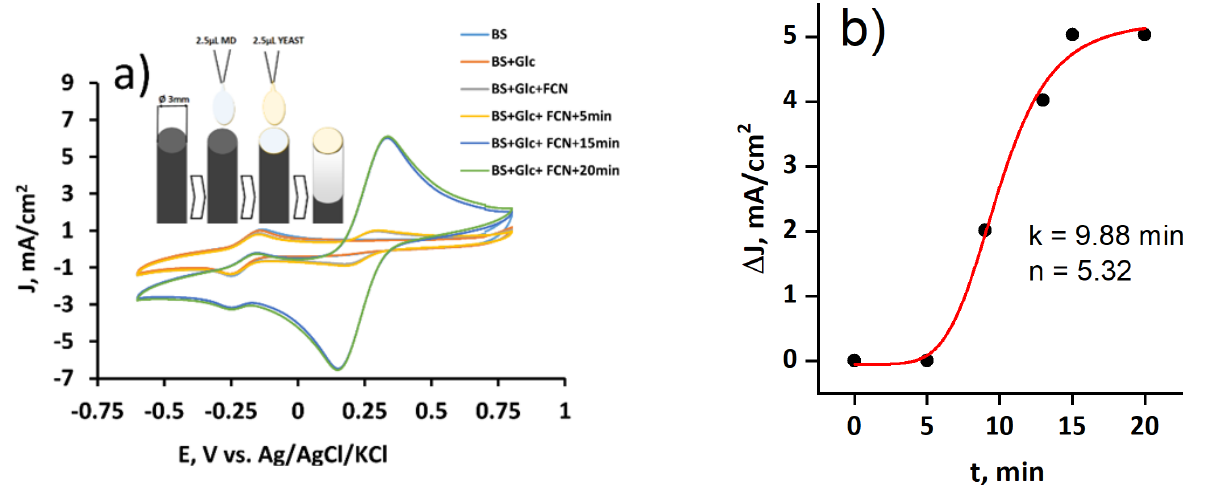
Figure 5. ( a ) Cyclic voltammograms of graphite electrode with immobilized MD and yeast cells registered in the phosphate–acetate buffer solution (BS) with the presence and absence of glucose (Glc) and potassium ferricyanide (FCN); ( b ) reduction peak current density at 0.4 V vs. used MD concentration recorded using an immobilized MD- and yeast-modified graphite electrode (results were fitted using Hill’s function (Equation (2)). Measurements were performed in a three-electrode-based electrochemical cell in the phosphate–acetate buffer solution with 23 mM glucose and 23 mM potassium ferricyanide.